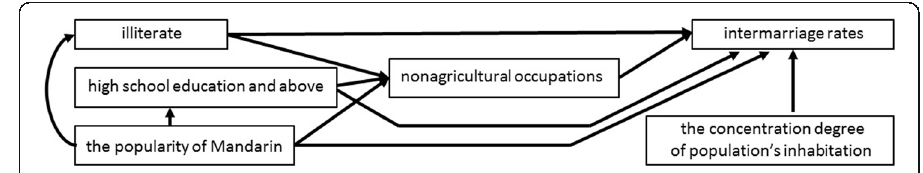
Fig. 2 The analysis model of factors influencing intermarriage